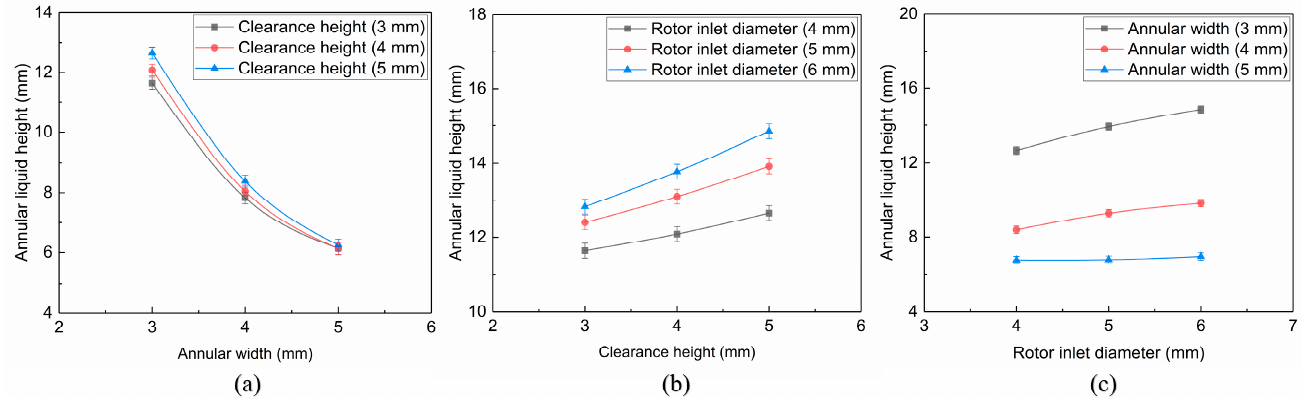
Figure 4. Variation in annular liquid height under different ( a ) annular widths with rotor inlet diameter of 6.0 mm; ( b ) clearance heights with annular width of 3.0 mm; ( c ) rotor inlet diameters with clearance height of 5.0 mm.